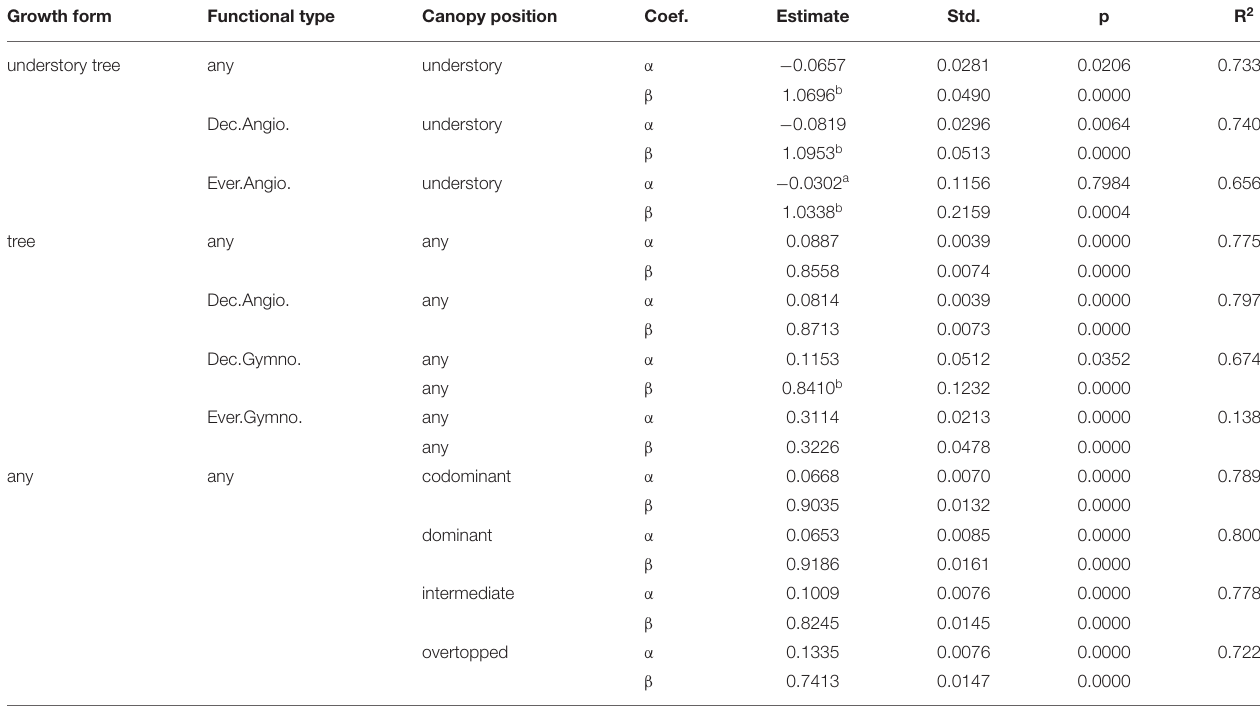
TABLE 3 | Linear models relating tree average branch basic density to average stem basic density (g cm − 3 ) for trees of different growth form and functional type in different positions within forest canopies.